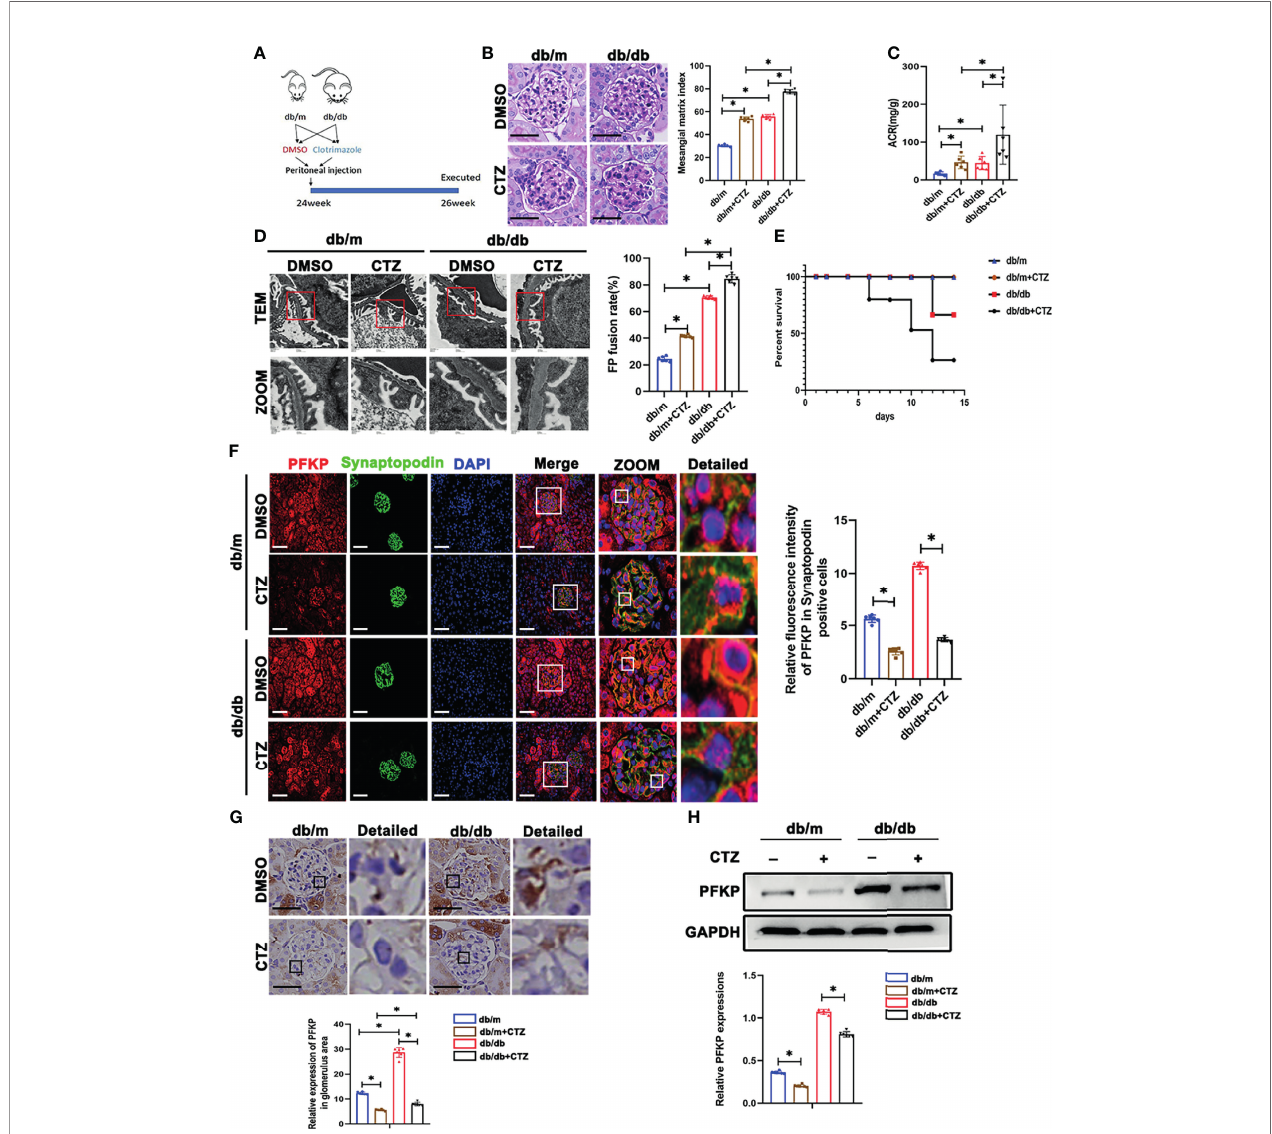
FIGURE 4 | Suppression of PFKP overactivation aggravated renal damage in db/db mice. (A) Schematic diagram of Clotrimazole administration in advanced db/db mice. (B) Representative microscopy images and quanti fi cation of PAS staining of kidney sections in each group (original magni fi cation ×400). (C) Quantitative of ACR (albumin-to-creatinine ratio) in each group. (D) Representative transmission electron microscopy images of the ultrastructure of capillary loops in each group (original magni fi cation×8,000, ×12,000). (E) Survival curve of db/m and db/db mice treated with CTZ over time. (F) Representative immuno fl uorescence staining of podocytes PFKP in each group. Synaptopodin was used as the podocyte marker. (G) Representative immunohistochemistry staining of glomerular PFKP in each group. (H) Western blotting analysis of PFKP expression in glomeruli of each group. GAPDH was set as loading control. For all fi gures, n=6 independent experiments/group. * P < 0.05. Scale bars: 20 µm, CTZ, Clotrimazole; PFKP, Phosphofructokinase 1 platelet